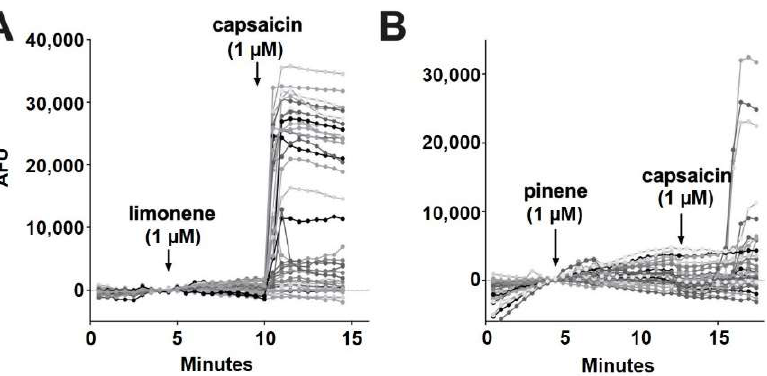
Figure 7. Limonene and pinene did not activate calcium responses in DRGs. ( A ) Sample popula- tion response using a calcium sensor in DRGs treated with limonene (1 µ M) followed by capsaicin (1 µ M). ( B ) Population response to pinene (1 µ M) treatment as in A.